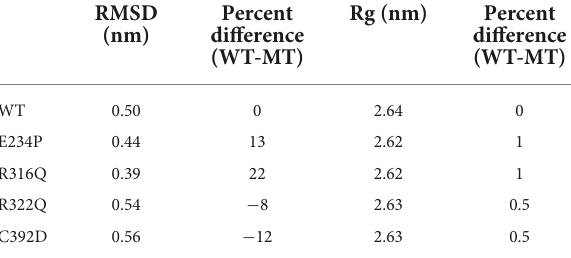
TABLE 3 Mean RMSD and Rg of WT and MTs and the percentage difference between